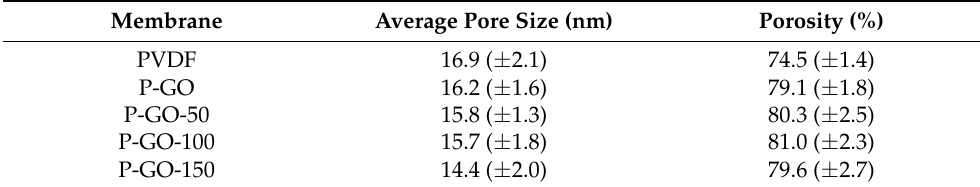
Table 2. Average pore size and porosity of membranes.